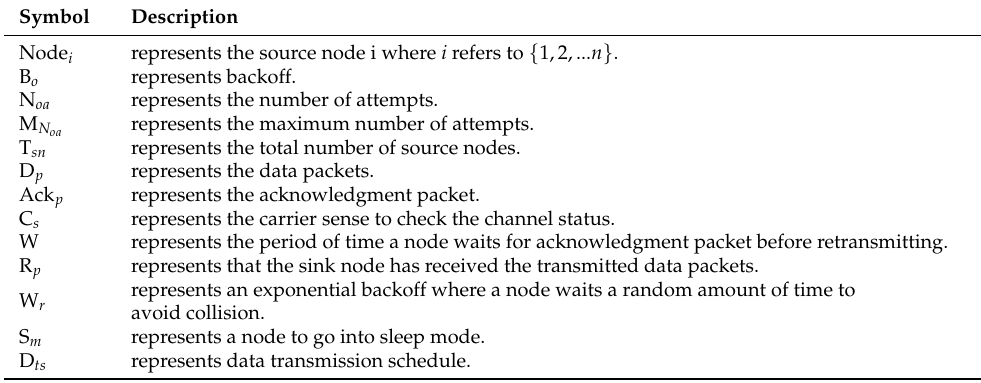
Table 5. DAMAC Reference